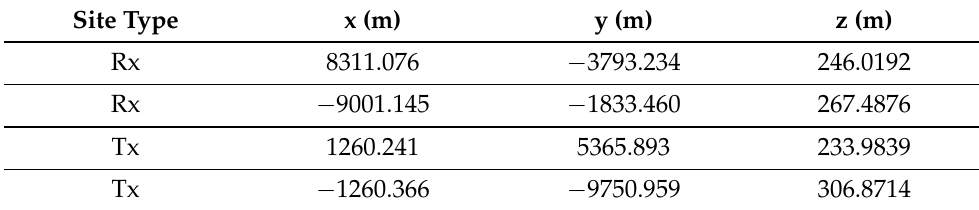
Table 1. Cartesian coordinates of four site positions, two receivers (Rx) and two transmitters